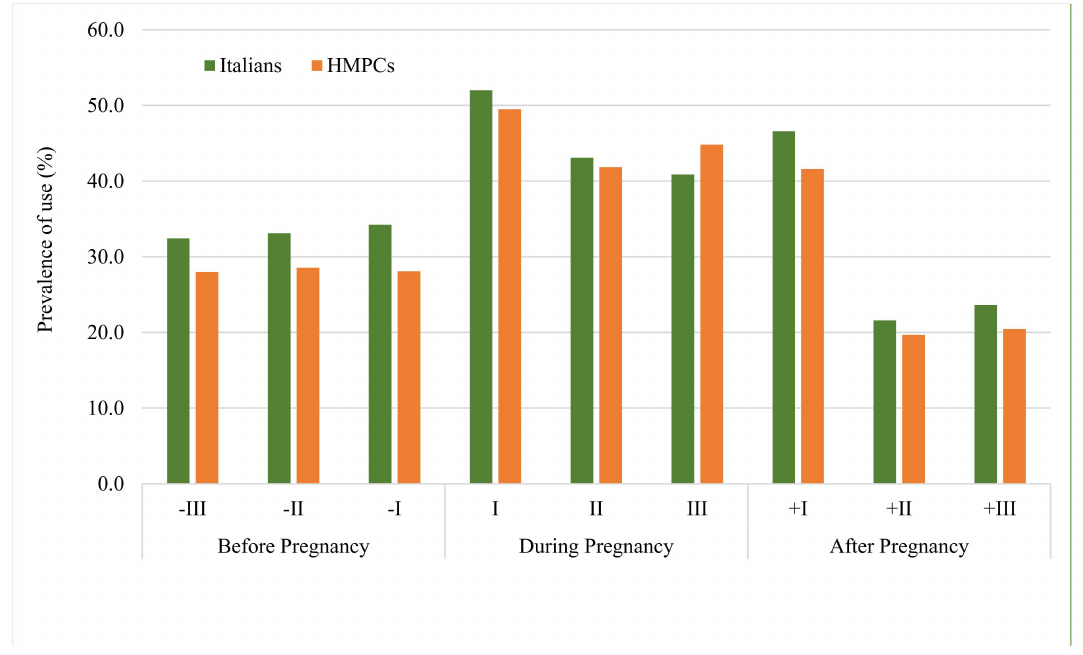
Figure 1. Prevalence of drug use (%) by trimester before, during and after pregnancy.